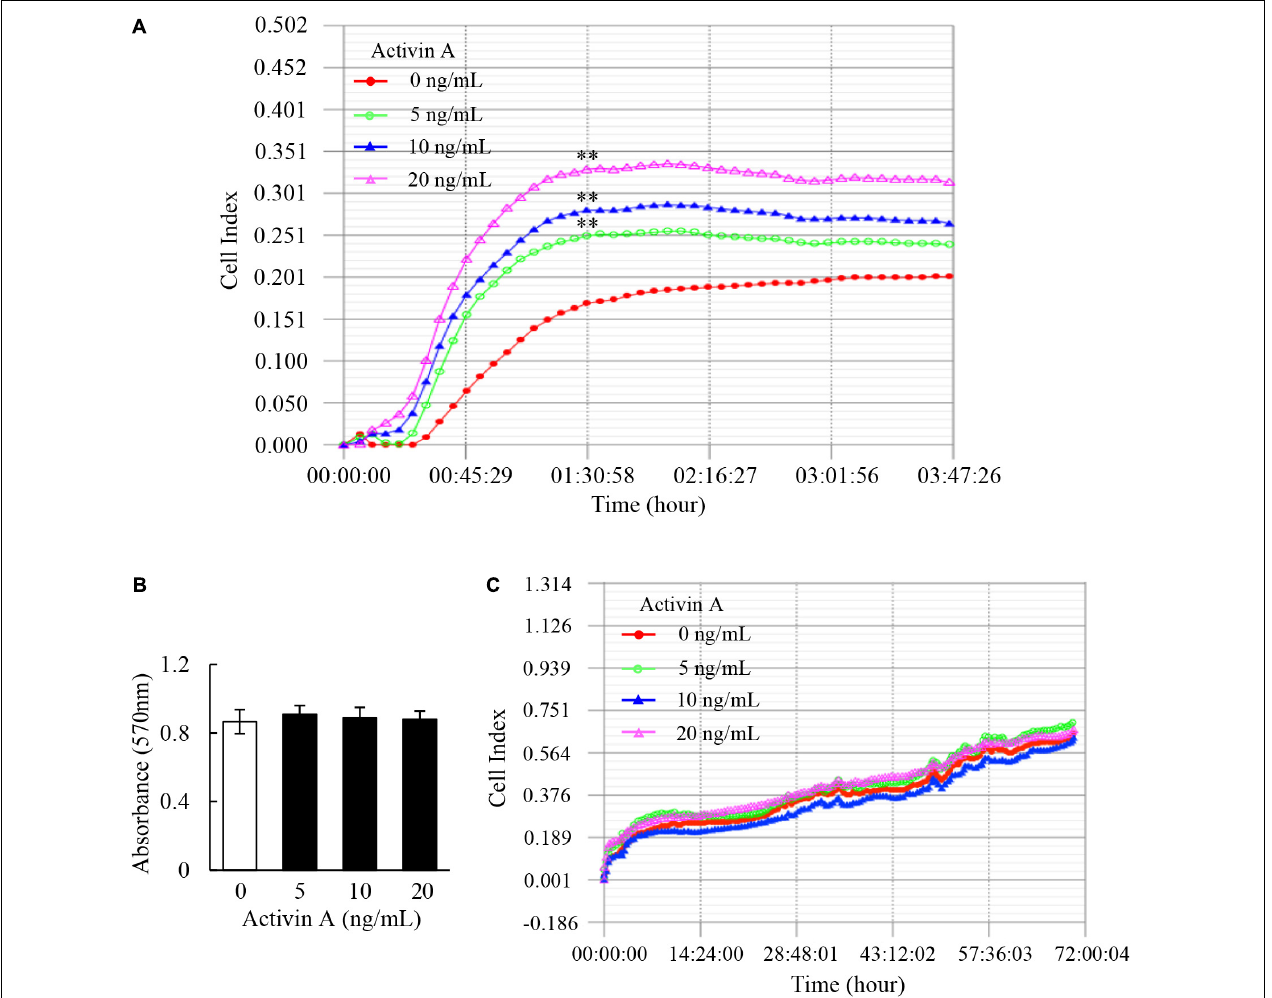
FIGURE 1 | Effects of activin A on adhesion and proliferation of L929 cells. (A) Real-time cell adhesion was assessed by RTCA in L929 cells subject to activin A at different concentrations for 4 h. ∗∗ P < 0.01 compared with the 0 ng/ml control group. (B) MTT assay was performed to assess the viability of L929 cells treated with activin A at different concentrations for 24 h. Data represent mean ± SD ( n = 6). (C) Real-time cell proliferation of L929 cells was assessed by RTCA in 70